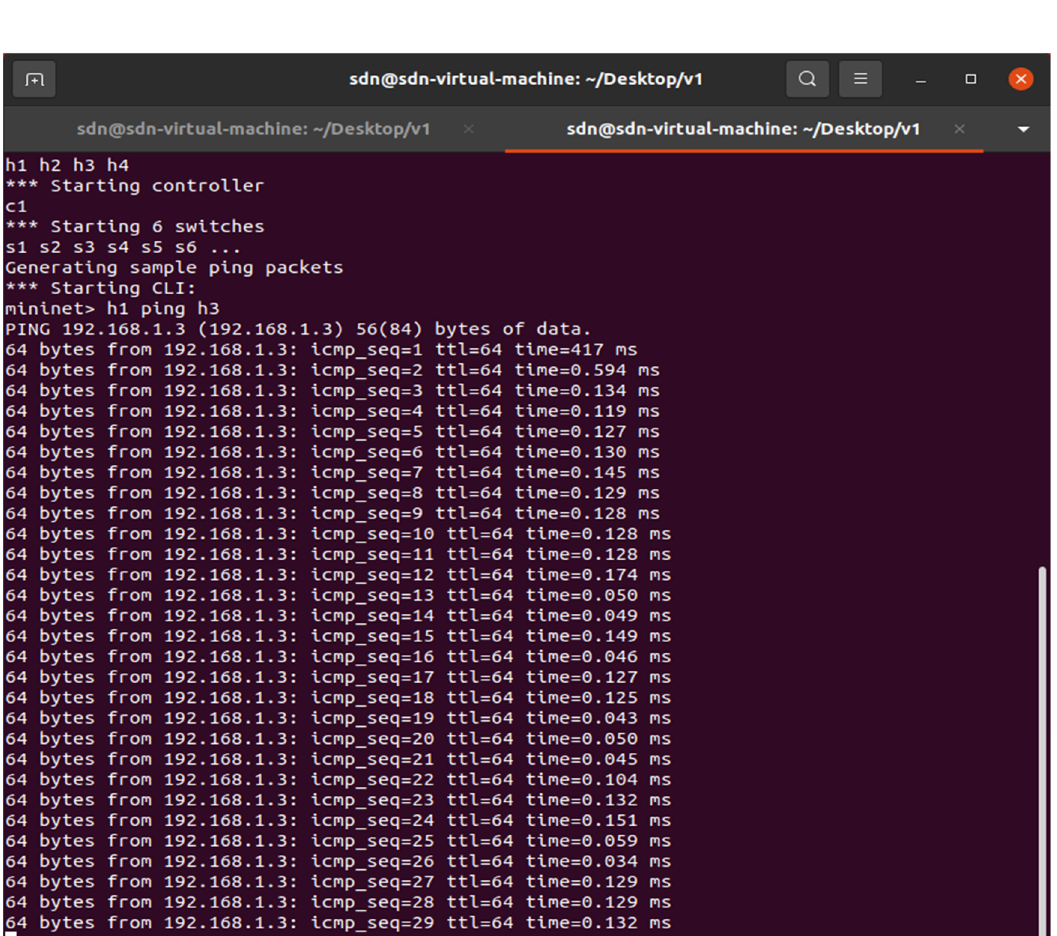
Figure 5: Adding of switches and links.